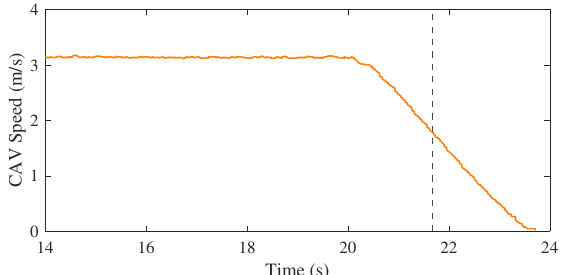
Figure 23. The CAV speed between time 14 to 24 s in the experiment. It is shown that the CAV started to decelerate about 1.5 s prior to the moment the pedestrian physically stepped onto the crossing, as indicated by the black dashed